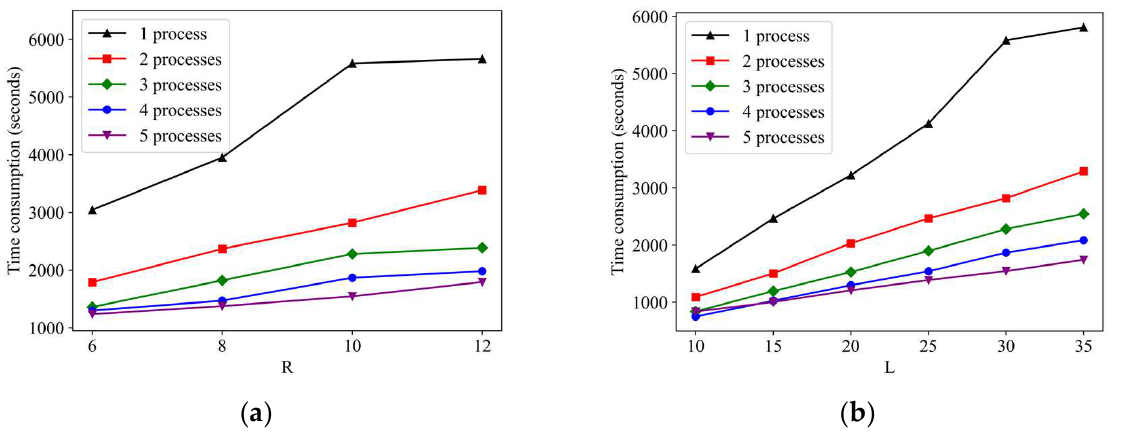
Figure 11. Random walk calculation efficiency under the different hyperparameter settings, including: ( a ) R : the number of sequences generated from each starting node; ( b ) L : the length of the sequence generated by the random walk. 1